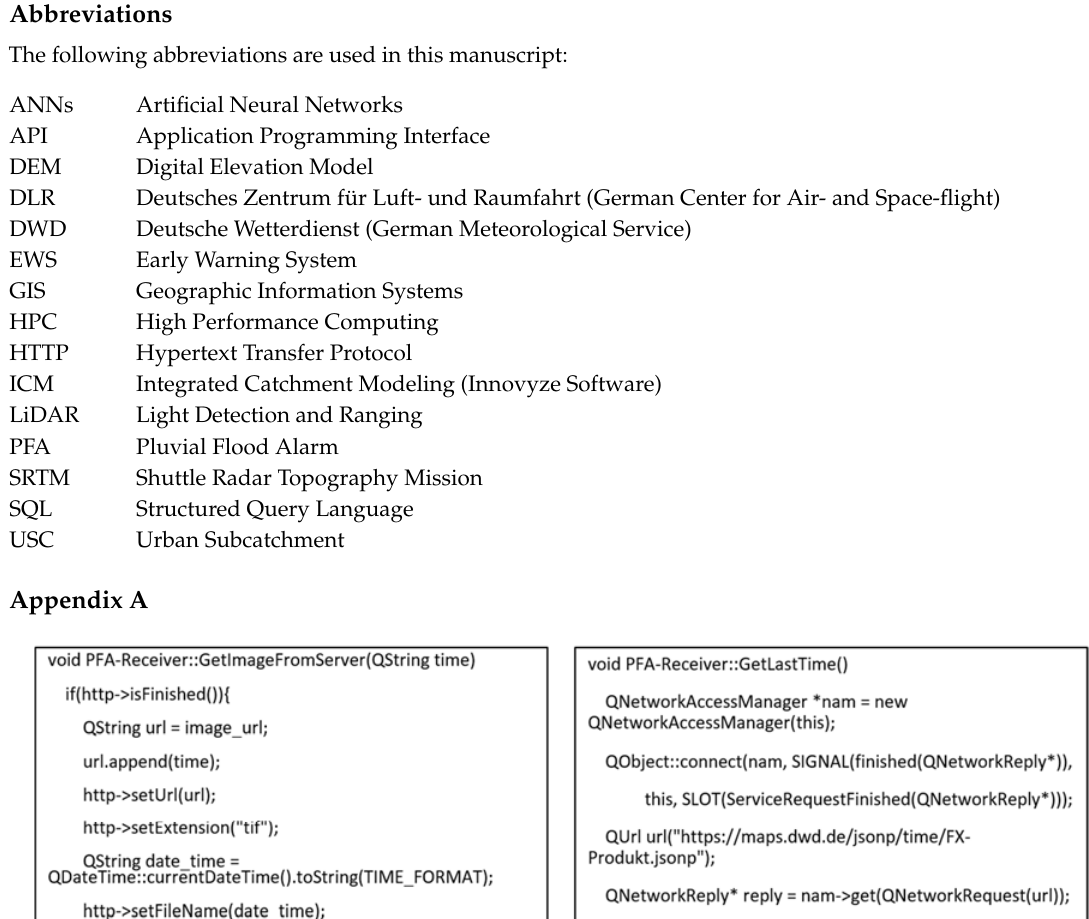
Figure A2. Example of the PFA code for the implantation of the model broker to activate a simulation. References 1.